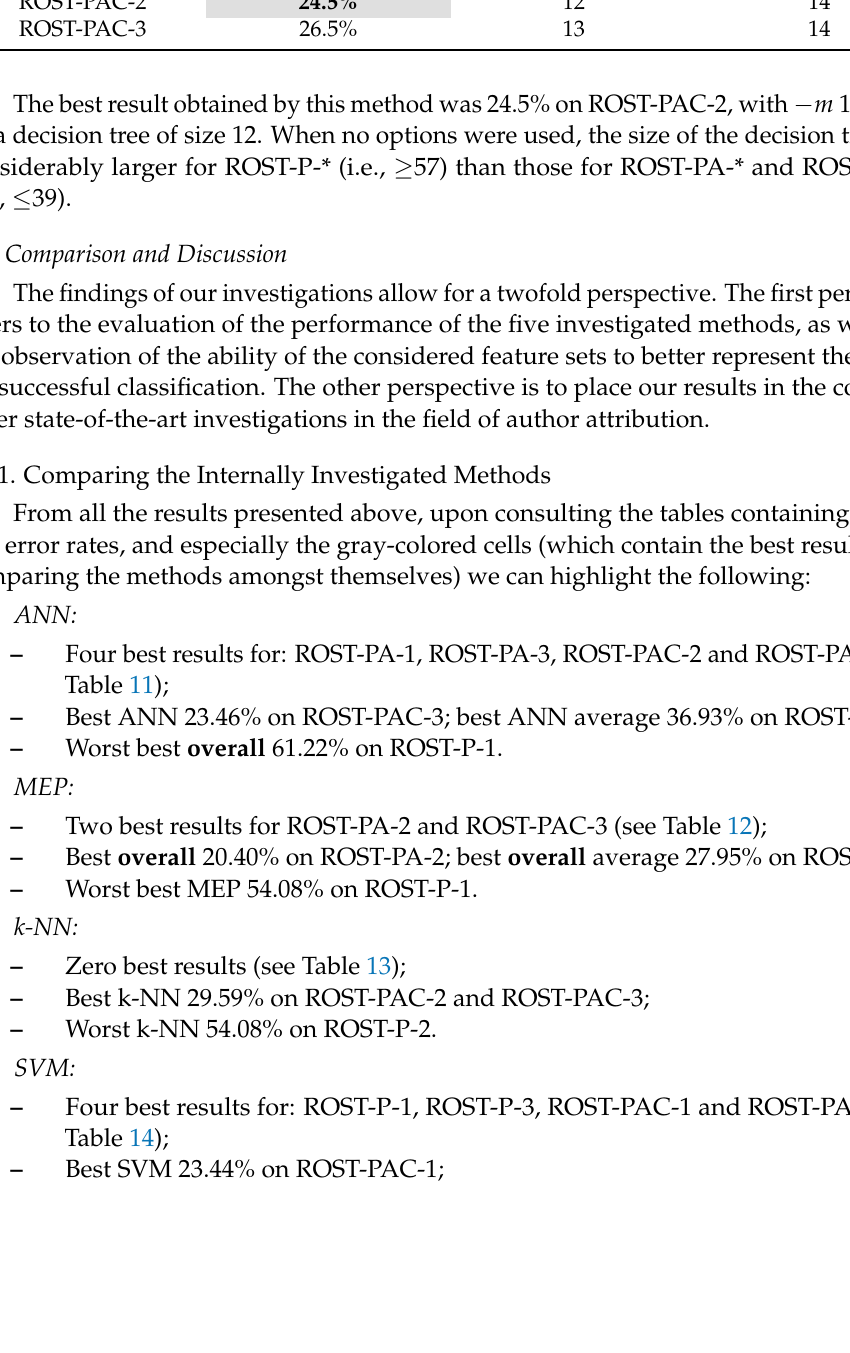
Table 15. Decision tree results on the considered datasets. The number of incorrectly classified data is given as a percentage (the best results obtained by DT with C5.0 on any ROST-*-* dataset representation are in bold). Error stands for the test error rate, Size stands for the size of the decision tree required for that specific solution and cases stands for the threshold for which is decided to have two more that two branches at a specific branching point ( cases ∈ { 1,2, . . . ,30 } ). The best result obtained by DT with C5.0 compared to all methods for a given ROST-X-n dataset representation is in a gray cell. Dataset Error Size Cases ROST-P-1 51.0% 18 8 ROST-P-2 51.0% 46 3 ROST-P-3 57.1% 99 1 ROST-PA-1 31.6% 13 12 ROST-PA-2 26.5% 57 1 ROST-PA-3 29.6% 31 3 ROST-PAC-1 28.6% 39 2 ROST-PAC-2 24.5% 12 14 ROST-PAC-3 26.5% 13